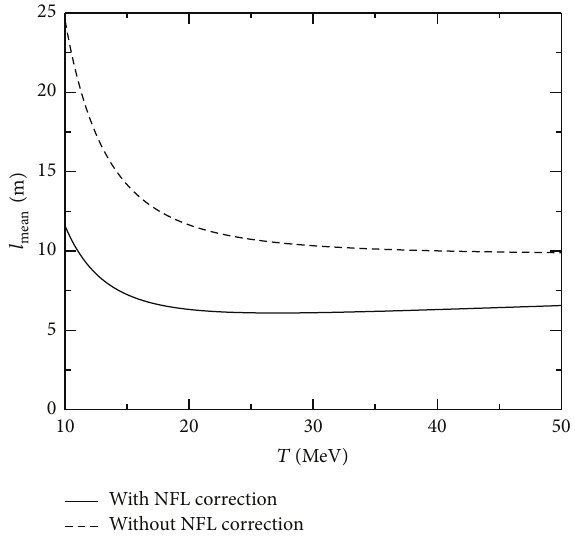
Figure 5: Neutrino mean free path in quark matter for degenerate neutrinos [3].